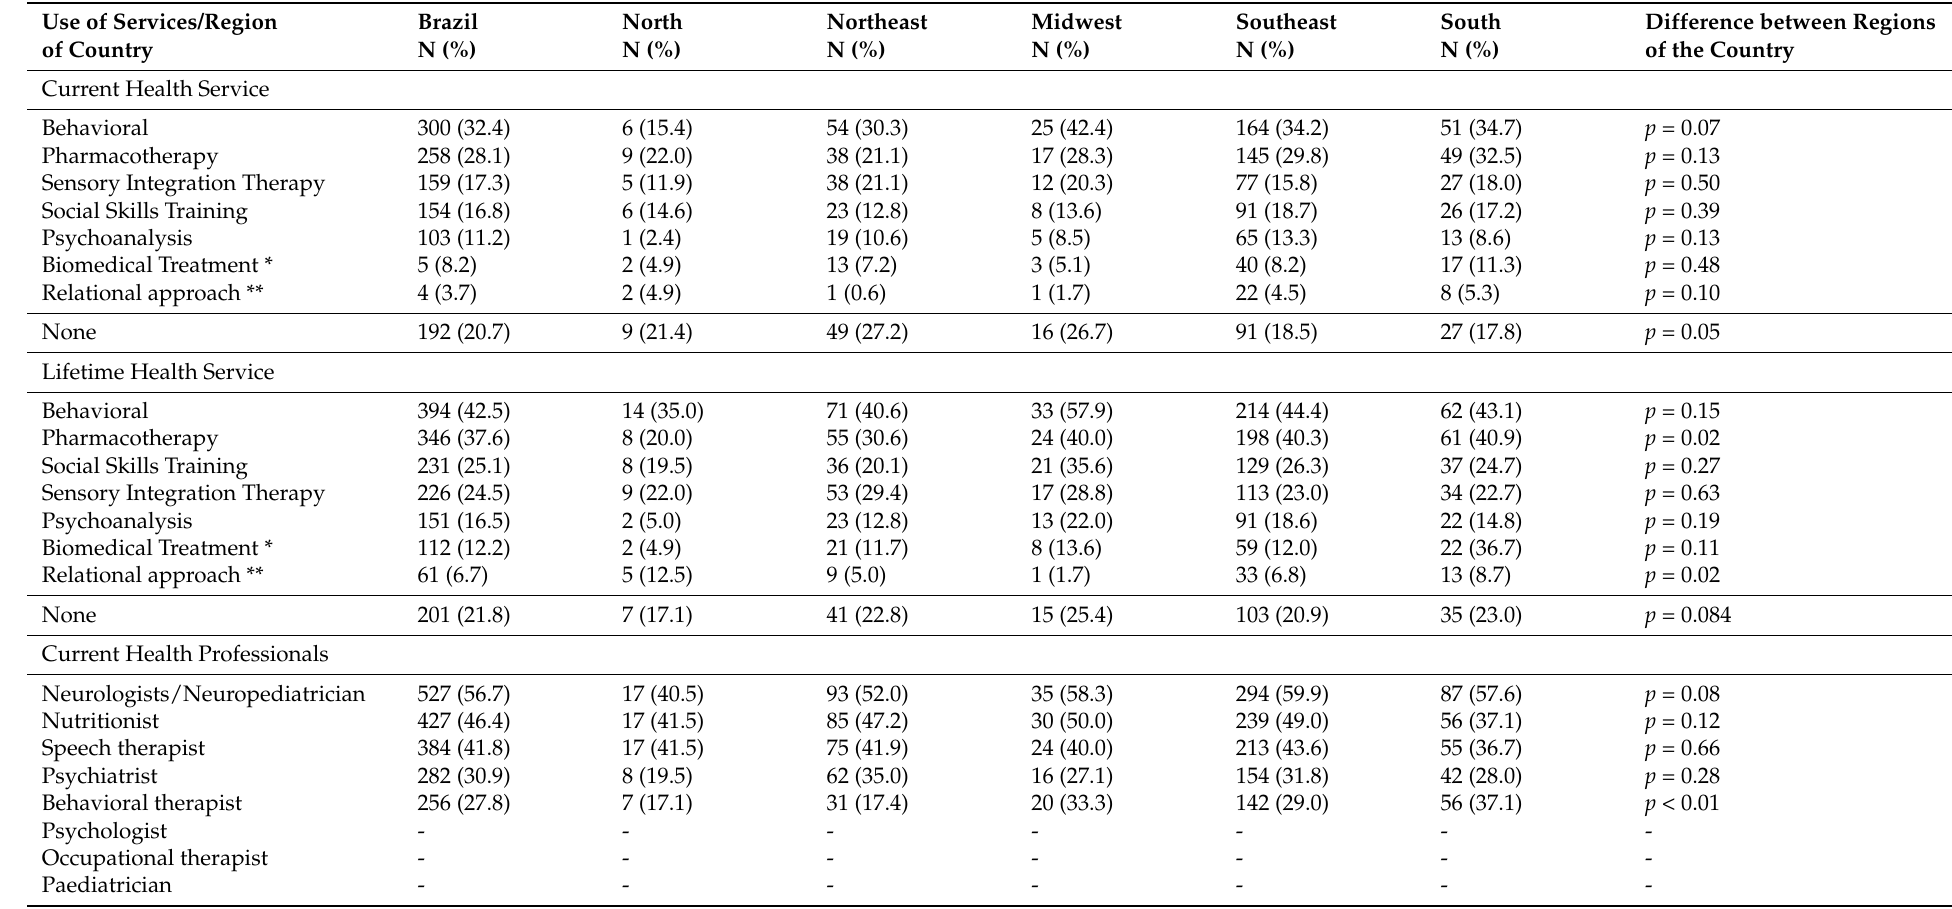
Table 2. Description of use of health and education services by type of approach and professional, current and past (N =